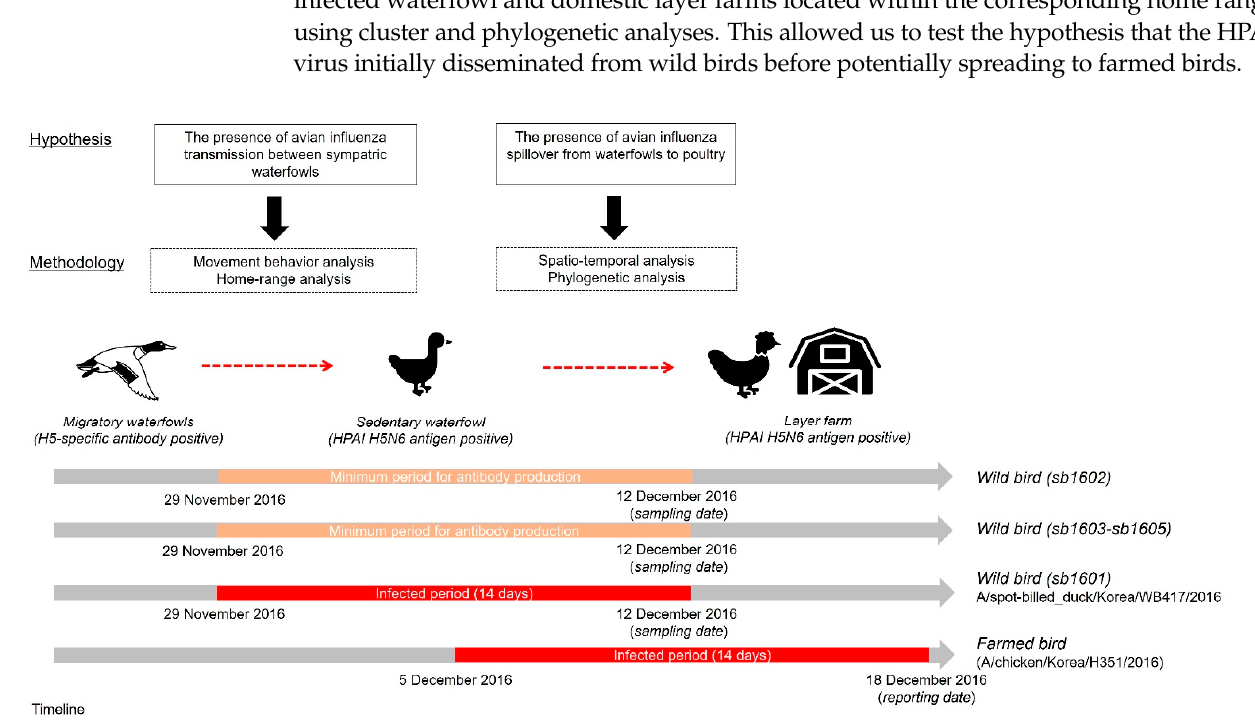
Figure 2. Study framework for testing the hypothetical relationship of wild birds, including migratory and sedentary waterfowl, alongside poultry farms. The red square represents the maximum infected period, assumed to have been 14 days before the sampling date, while the bright ivory denotes the duration of antibody detection, assumed to start from at least 14 days before the detection